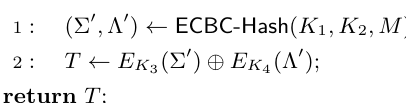
Figure 6.3: Algorithm for SUM-ECBC and 3kf9